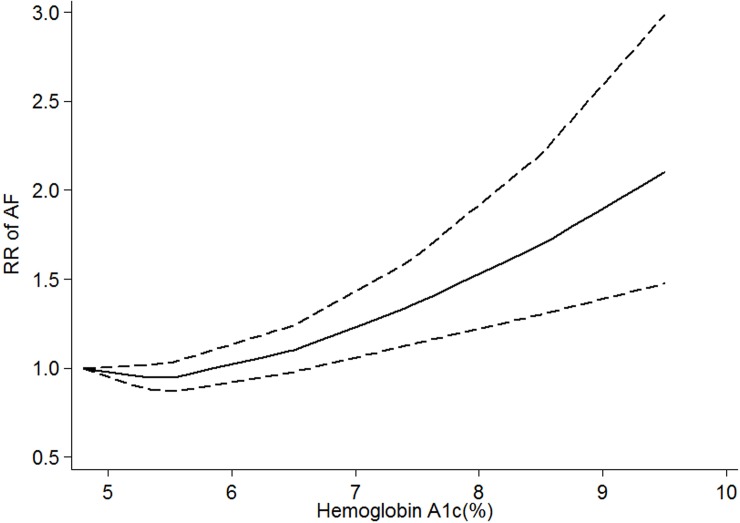
HbA1c and risk of atrial fibrillation in patients with unknown diabetes, nonlinear dose-response analysis.The solid line and the dashed lines represent the estimated relative risk and the 95% confidence interval, respectively.